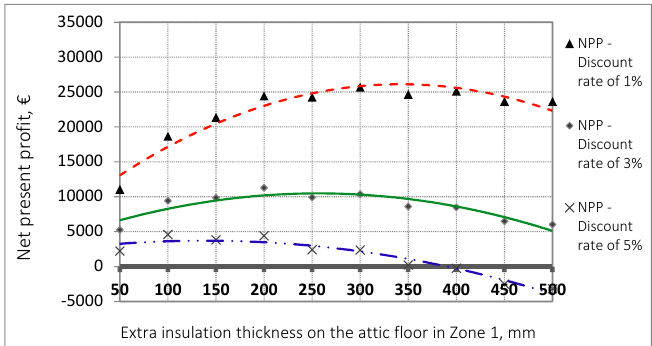
Figure 15. Net present profit of additional insulation on the attic floor for different discount rates in climate Zone 1.